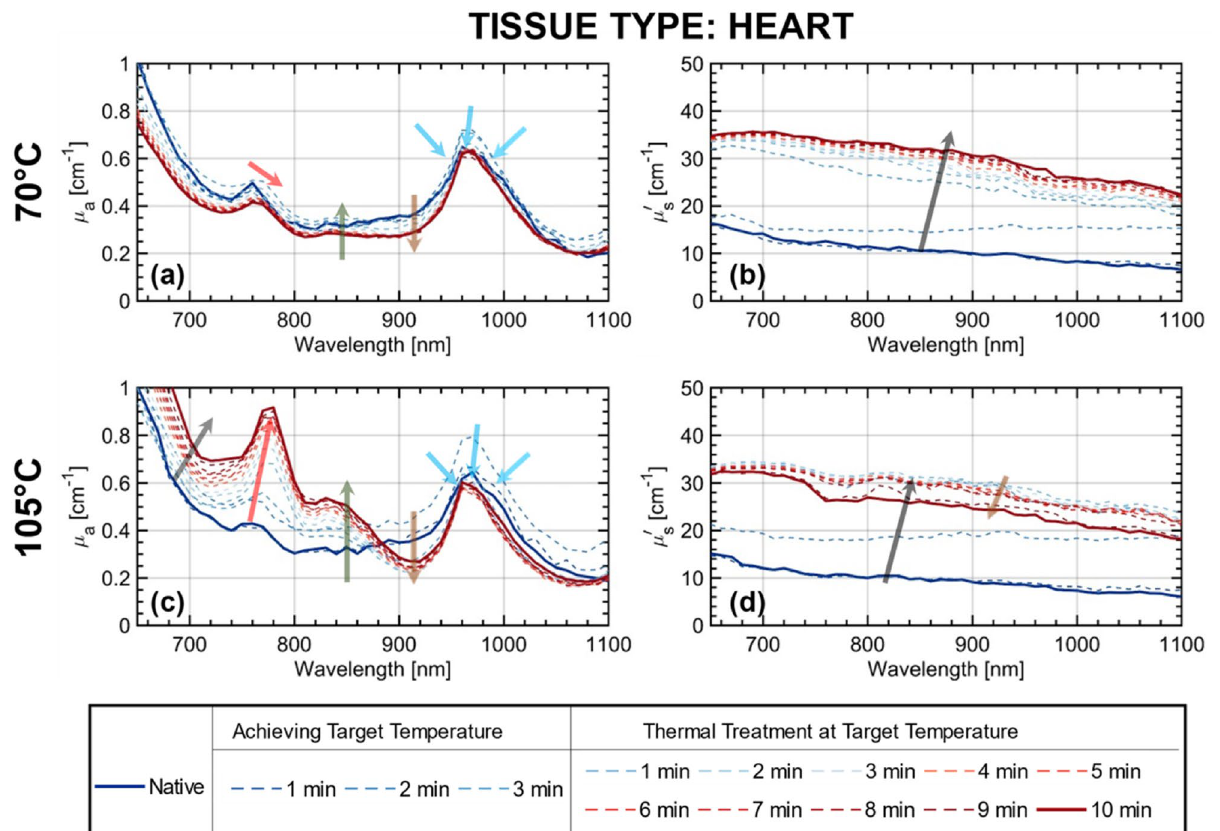
Figure 3. Evolution of the optical property spectra with RF treatment of ex-vivo bovine heart tissue— Broadband absorption μ a ( a ) and ( c ) and reduced scattering coefficient μ ʹ s ( b ) and ( d ) spectra during the RF-based thermal treatment at the two temperatures, 70 °C and 105 °C are shown. The acquisition time per spectrum is 1 min. The RF instrument takes a time of less than 3 min to achieve the target temperatures. The temperature is then maintained for a span of 10 min. Hence in total, a set of 13 spectra are acquired during the RF-based thermal